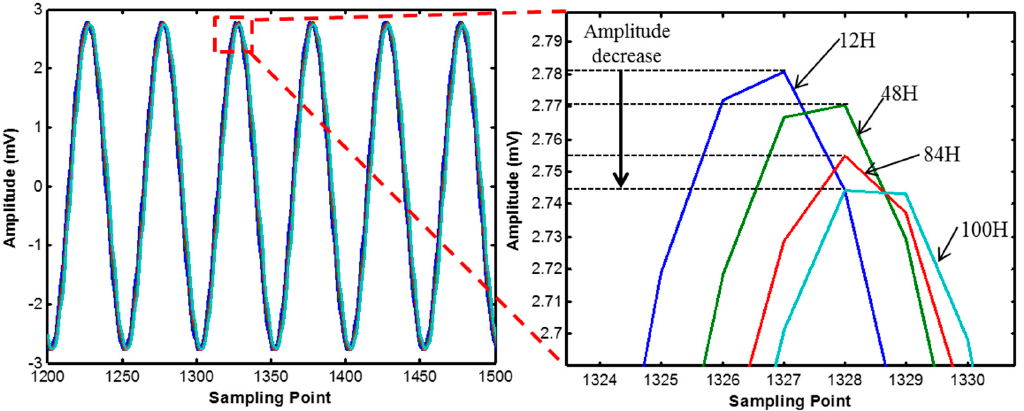
Figure 10. Harmonic wave signal variation of module 1.